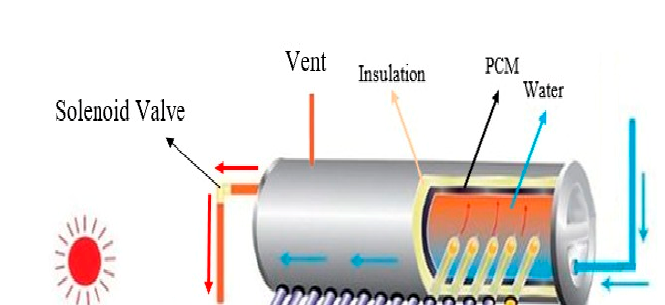
( b ) Figure 3. Hydronic evacuated tube solar system with a PCM: ( a ) photographic view; ( b ) schematic diagram. 2.2. Thermal Model Energy balance is applied to both parts of the hydronic solar system under steady- state conditions: the evacuated tube and hot water storage tank. The useful energy gained from solar radiation by evacuated tubes can be expressed by [40,41]: 𝑄 𝑢𝑠𝑒𝑓𝑢𝑙 = 𝐼 𝐴 𝑐 (𝜏𝛼) 𝑒𝑓𝑓 𝑘 𝜃𝑖 − 𝑄 𝑙𝑜𝑠𝑠 (1) and